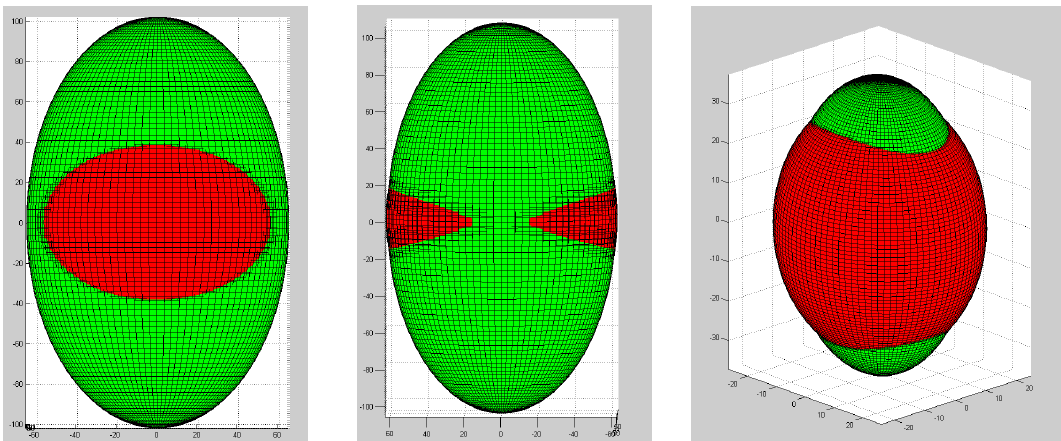
Figure 1. Angular momentum and kinetic energy ellipsoids of a prolate spheroid. The two left subfigures show the polhode (intersection of the two ellipsoids) about a minor axis of the prolate spheroid, in front view and side view. Note that there are two solutions and the ω -vector follows either the front or back polhode. If the two solutions merge, then the ω -vector follows either the top or bottom polhode (counterclockwise or clockwise spin) shown in the right